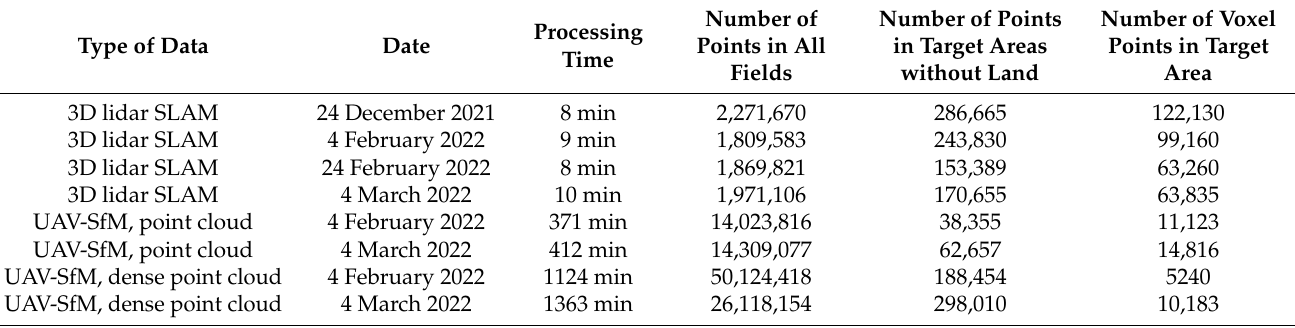
Table 1. Comparison of the point cloud models.